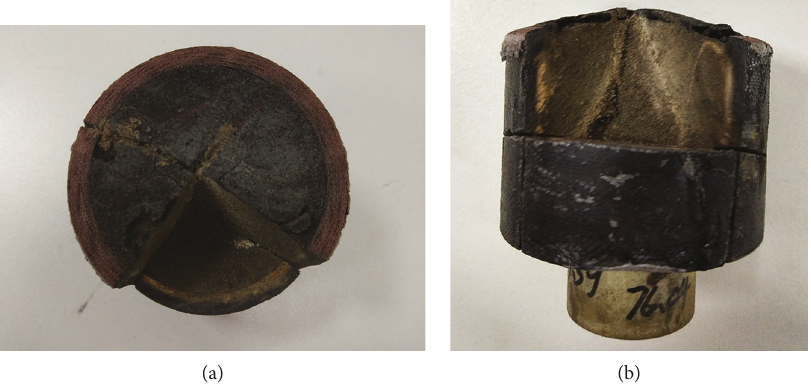
Figure 1: The specimen of ablative thermal insulation material: (a) vertical view (b) front view.